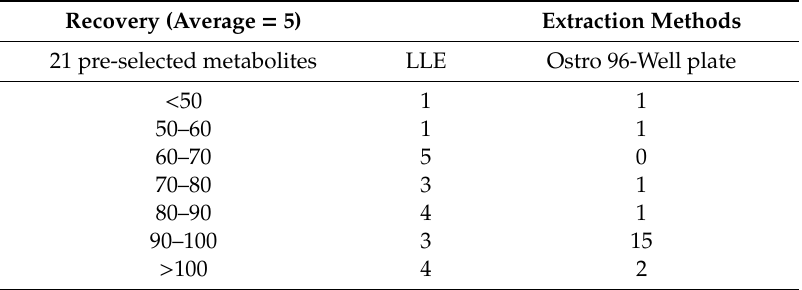
Table 3. Recovery obtained from analysis of 21 pre-selected metabolites using LLE or Ostro 96-well plate. The selected metabolites were: GABA, 2-AM, VAL, MET, ILE, LEU, DA, 5-HT, PHE, TYR,